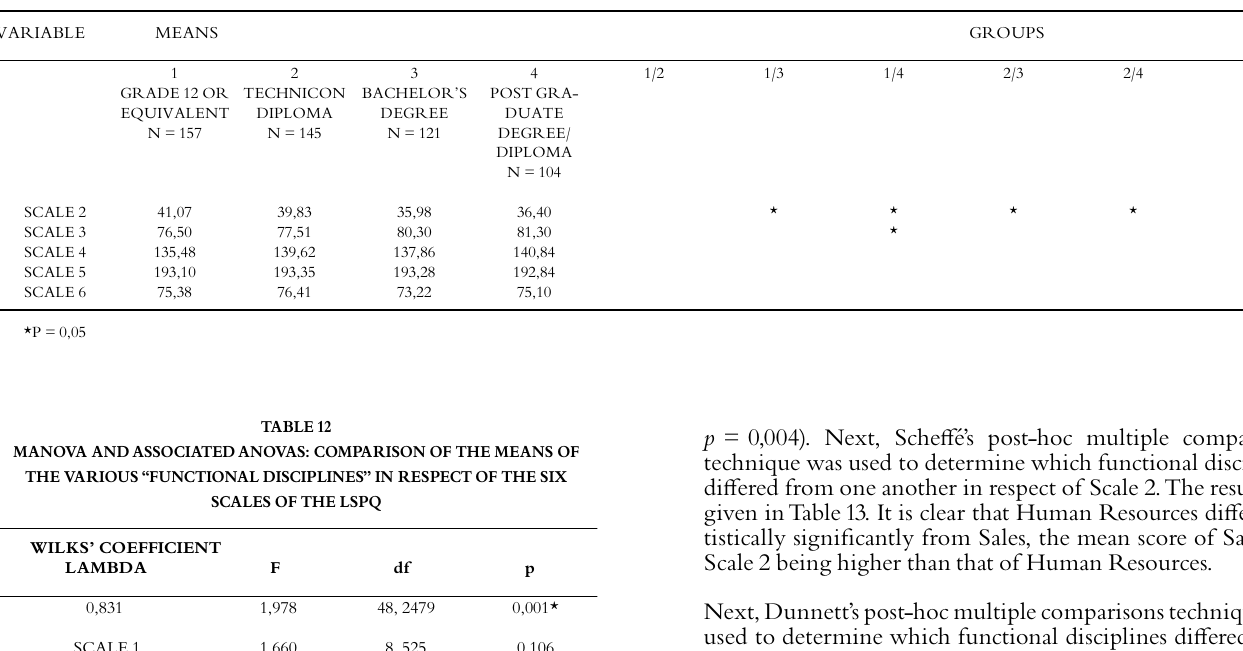
TABLE11 SCHEFFE¤ ’S POST-HOCMULTIPLECOMPARISONS: COMPARISONOF THE MEANSOF THEVARIOUS‘‘ACADEMICGROUPS’’IN RESPECTOF